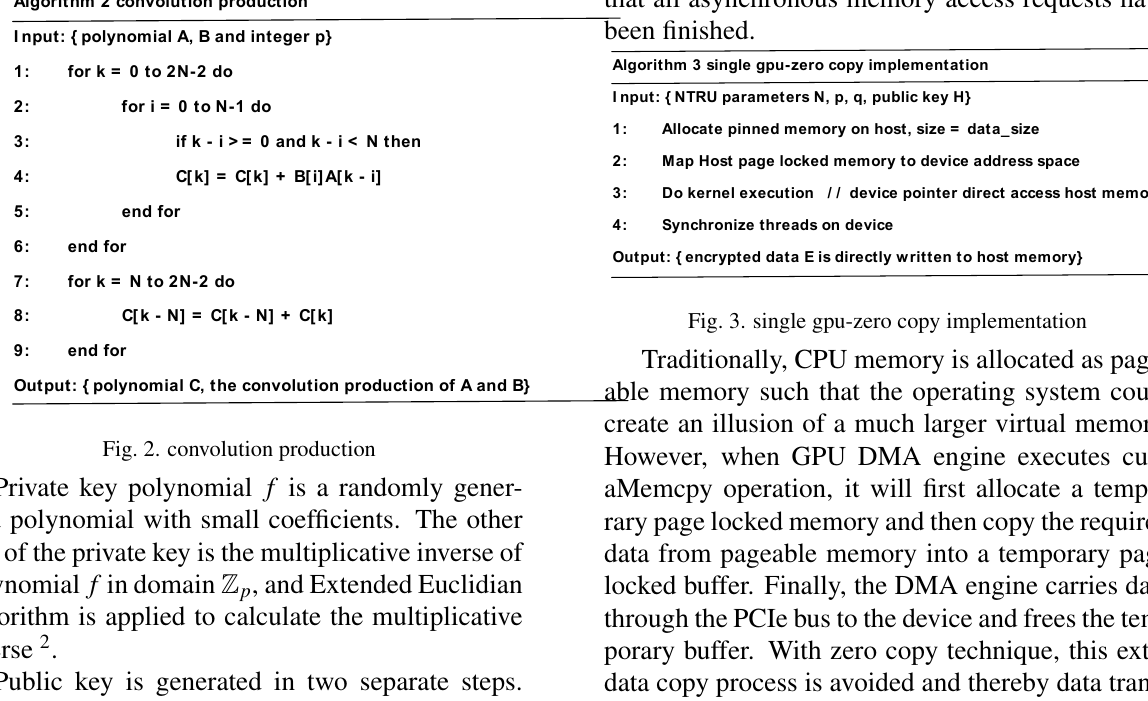
Algorithm 3 single gpu-zero copy implementation